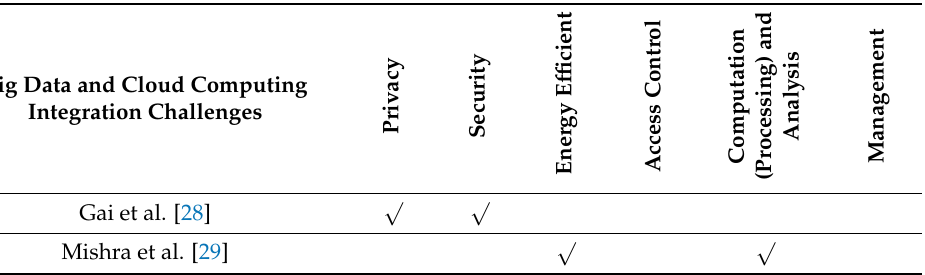
Table 7. Related work